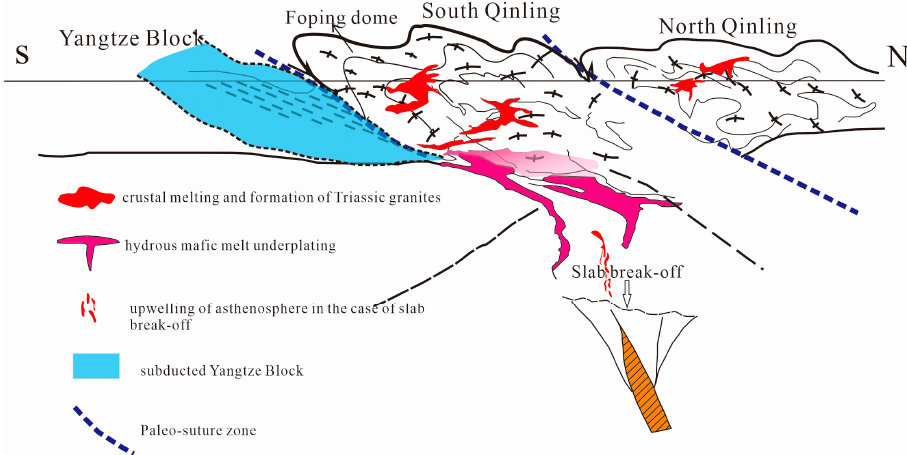
Figure 10. A simplified sketch tectonic cartoon model showing the formation of Triassic appinite and coeval granites in the Qinling orogenic belt.